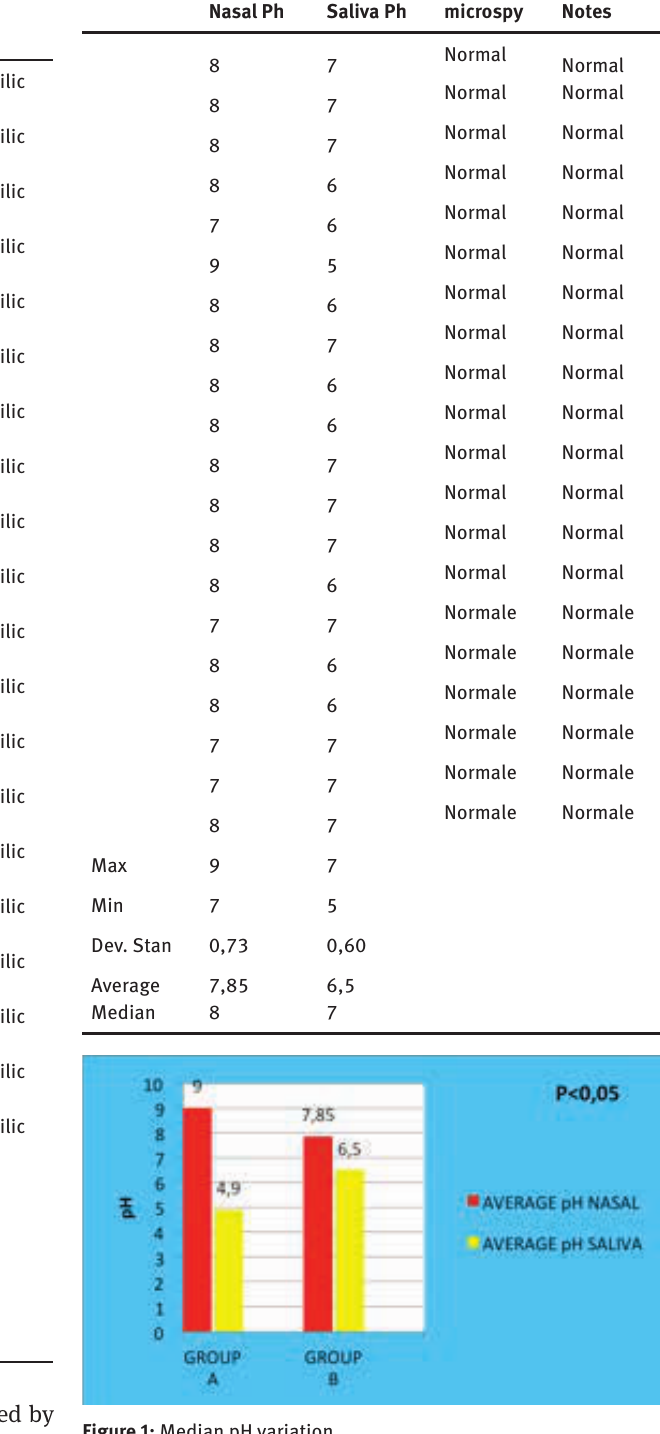
Figure 1: Median pH